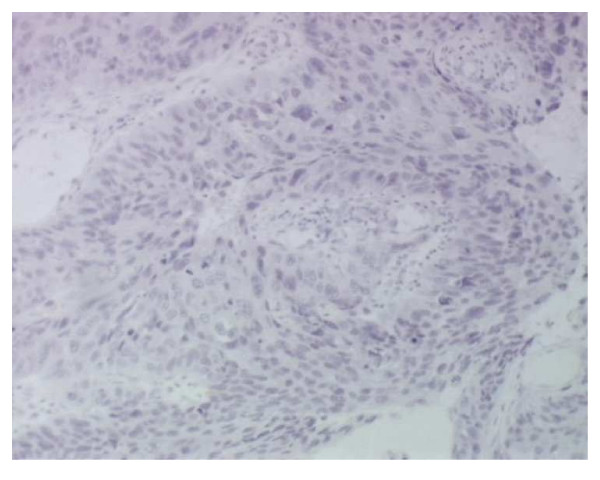
Example of immunohistochemistry for CA IX. Example of biopsy stained for CA IX (×100). This tumor showed a small positive percentage.